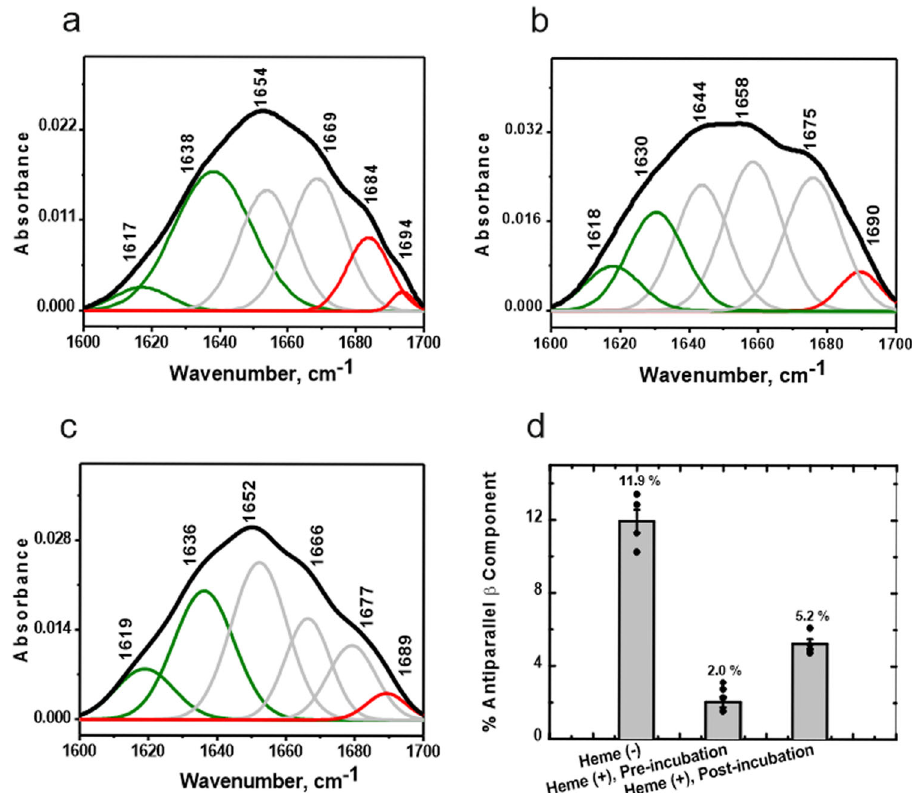
Fig. 3 Heme causes a major reduction in the antiparallel β sheet component of fi bril-forming aggregates. Deconvoluted FT-IR spectra of 24 h oligomers incubated a in the absence of heme; or b in presence of heme from the beginning of incubation period (oligomers 1 , preincubation); c depicts the IR spectrum of oligomers 2 formed when 48 h pre fi brillar and fi brillar aggregates were treated with heme, postincubation. d Addition of heme causes a drastic reduction in the antiparallel β sheet component (bands at ~1680 – 90 cm − 1 , Panels a – c , illustrated in red) of the resulting oligomeric population. The bands depicted in green denote the parallel β sheet component (1622 – 1638 cm − 1 ). Error bars are ±SEM obtained from four independent experiments. Second derivatives of the FT-IR spectra (Supplementary Fig. 5, SI) have been used to determine individual